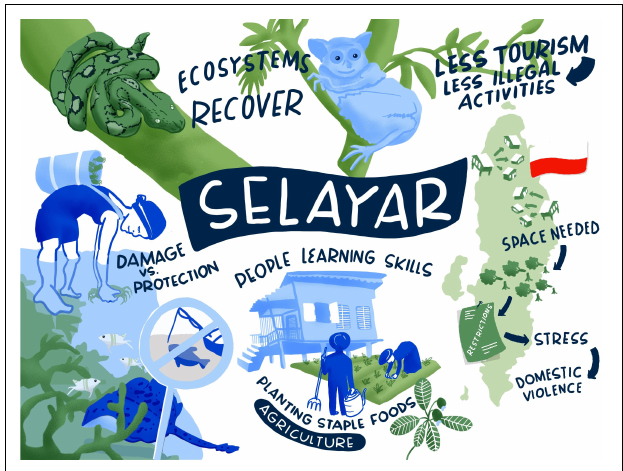
FIGURE 4 | COVID-19 scenario for Selayar. Illustration by Lina Ernst Illustrations.